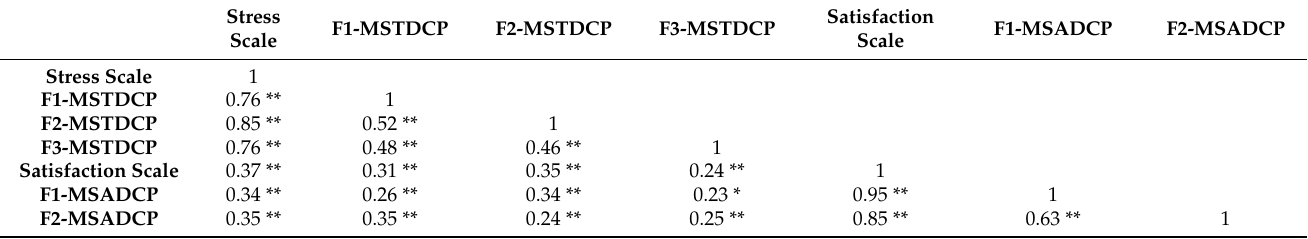
Table 13. Relationships between the scales and subscales of the exploratory factor analysis.